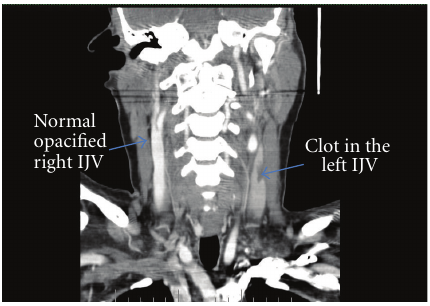
Figure 1: CT scan of the head and neck with contrast demonstrated a thrombus in the left internal jugular vein (IJV).